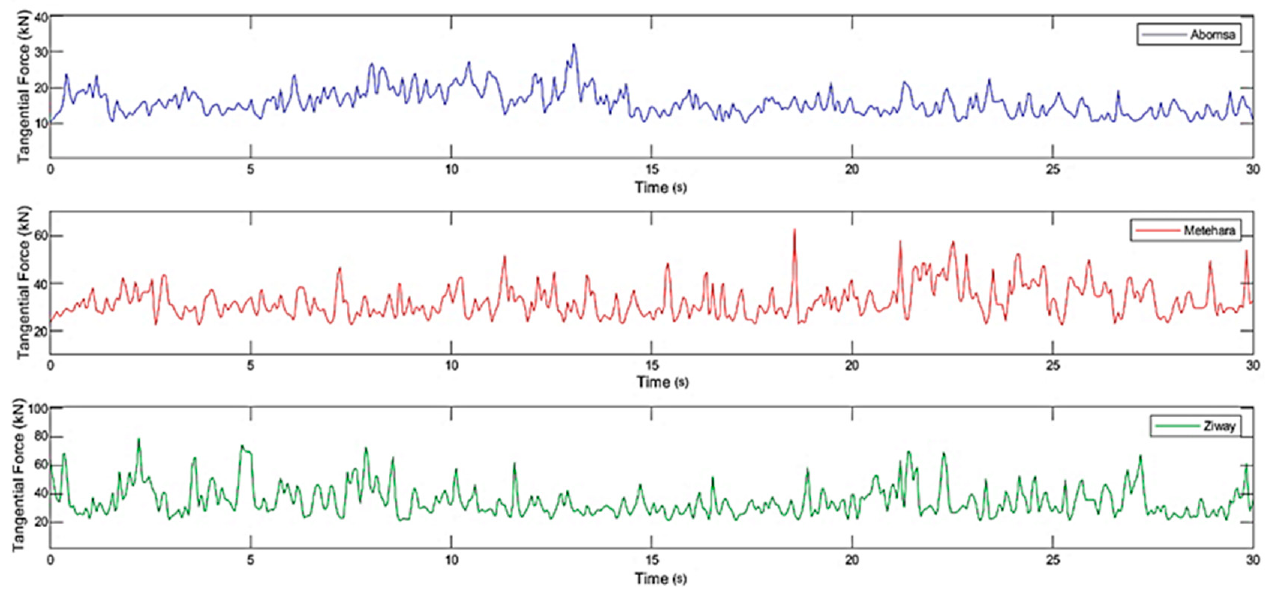
Figure 1. Structural wind turbine blade modeling. Figure 15. Tangential force acting on wind turbine blade for three selected sites.